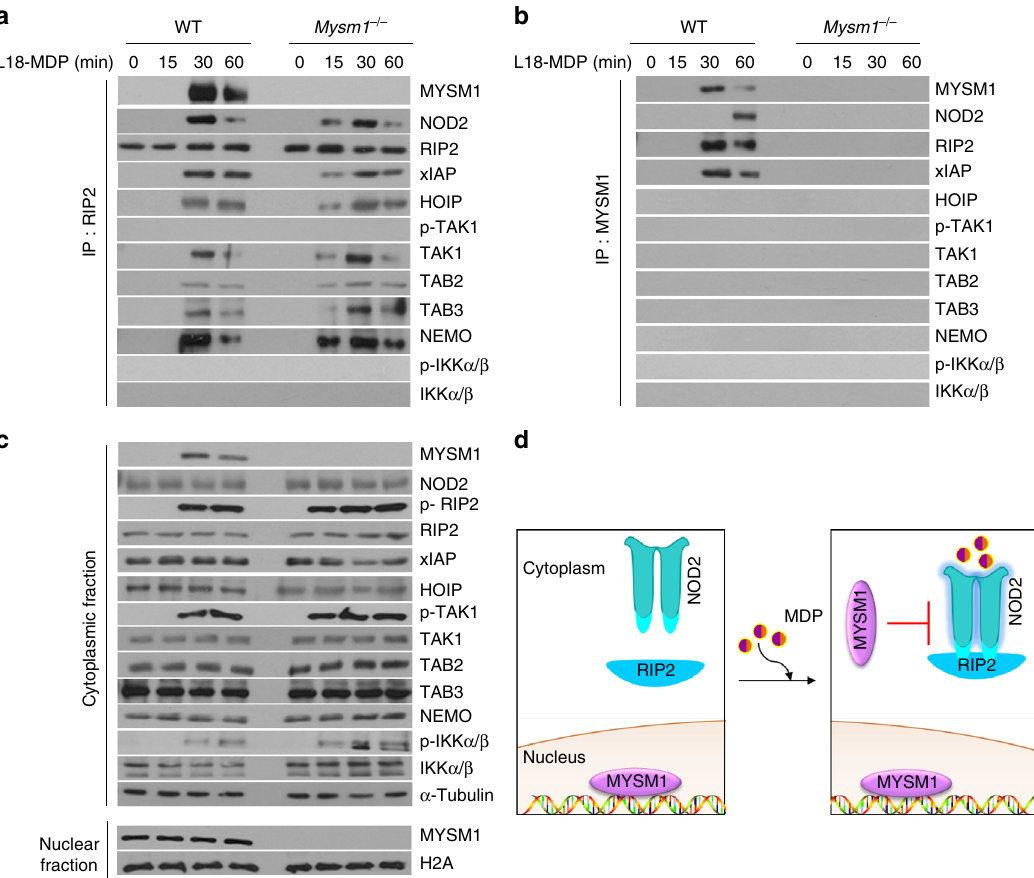
Fig. 4 MYSM1 interacts with and disrupts NOD2:RIP2 complex. a Cytoplasmic fractions from WT and Mysm1 − / − BMDMs stimulated with L18-MDP for indicated duration were immunoprecipitated with anti-RIP2 ( a ) or anti-MYSM1 ( b ). The pulldowns ( a, b ) and corresponding cytoplasmic or nuclear fractions ( c ) were immunoblotted for indicated proteins. d Schematic representation of MYSM1 subcellular localization before and after MDP stimulation. Data are representative of at least three independent